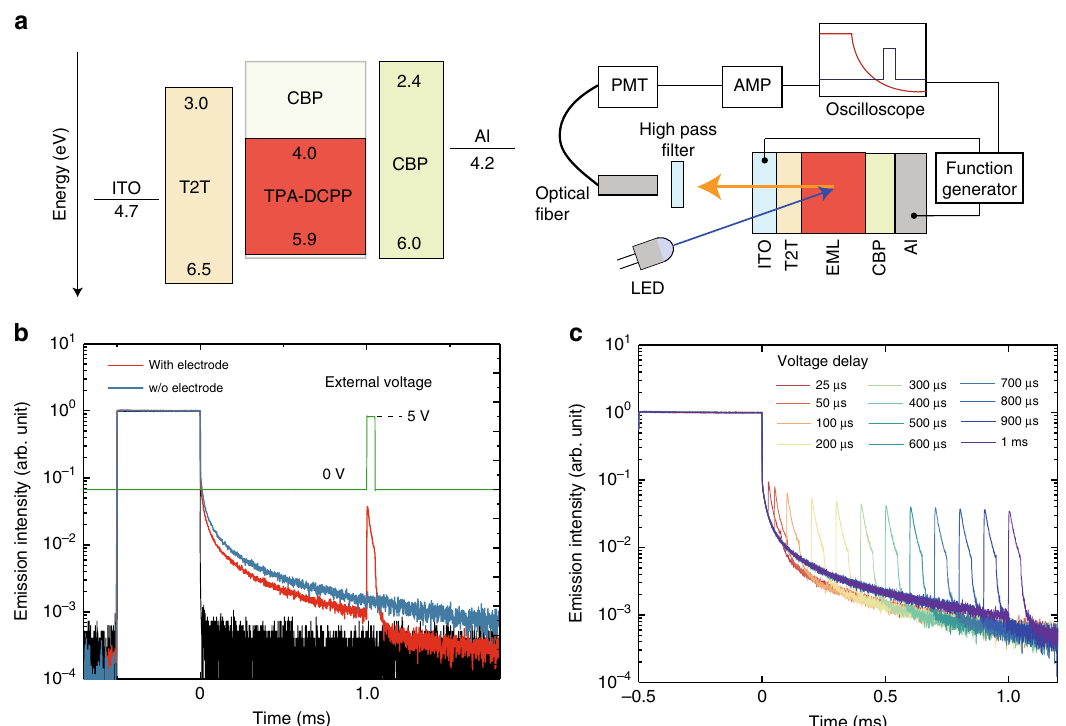
Fig. 2 Device structure, experimental set-up, and external-electric- fi eld-modulated luminescence. a Energy-level diagram of materials used in this work (left) and schematic of the experimental set-up for external-electric- fi eld-modulated luminescence measurements (right). ITO and Al electrode were used as anode and cathode, respectively. b External-electric- fi eld-modulated TRPL pro fi le in a device with a 50-wt%-TPA-DCPP:CBP blend (red line). The blue line is the TRPL pro fi le of a 50-wt%-TPA-DCPP:CBP blend (without electrodes or T2T and CBP layers) for comparison. The black and green line indicates the IRF in this measurement system and the time pro fi le of the external applied voltage, respectively. The excitation light pulse width was set to 500 µ s. c Dependence of the external-electric- fi eld-modulated TRPL pro fi les on external-voltage-pulse delay in the 50 wt%-TPA-DCPP:CBP device. The applied voltage and the width were fi xed to 5 V and 50 µ s, respectively. Note that it is not a multiple voltage pulses. This experiment used independent voltage pulses for each timing, and multiple measurements were